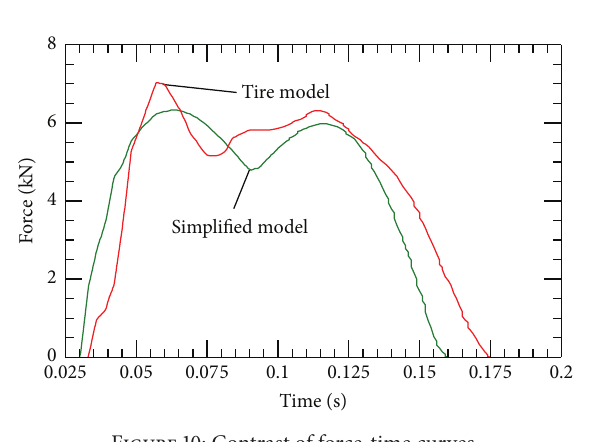
Figure 9: Calculation model of tire.